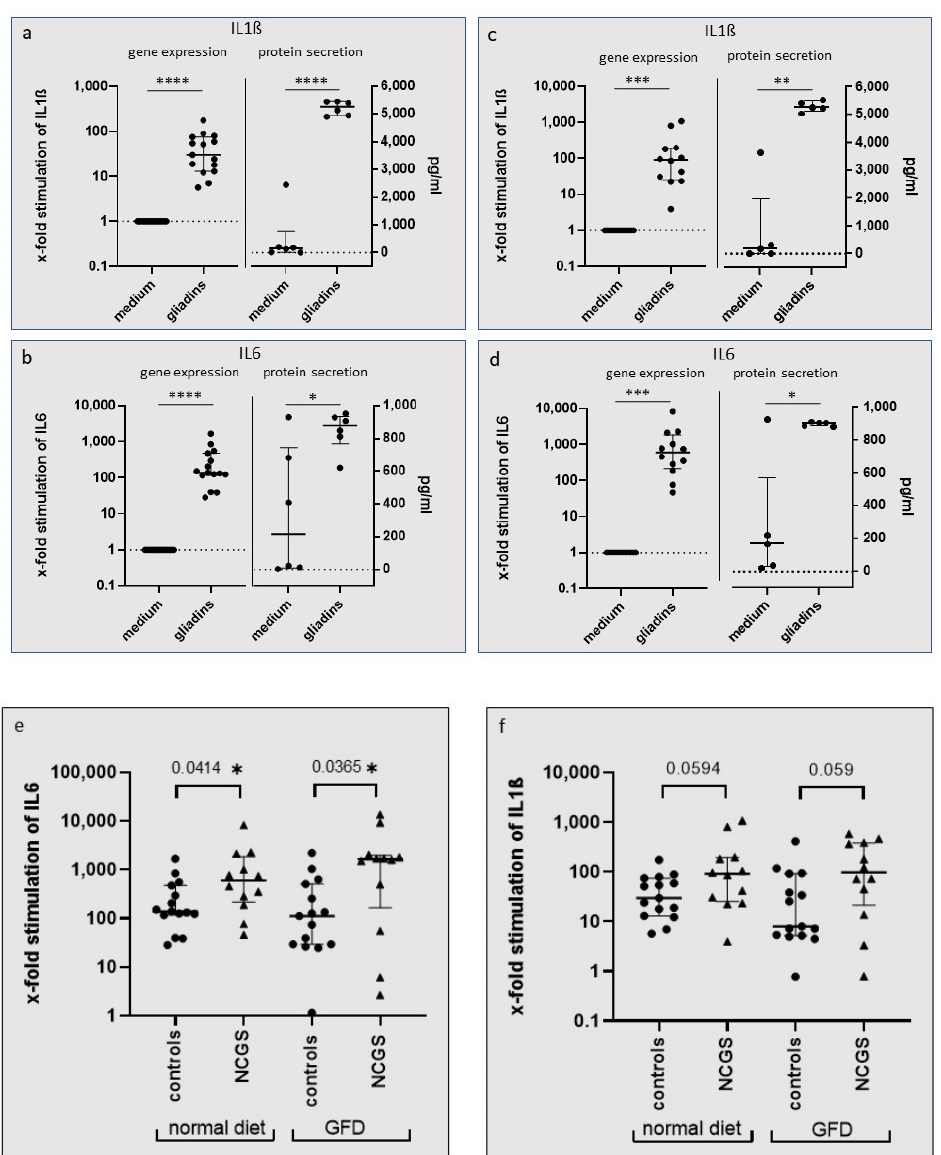
Figure 1. Gene and protein expression of PBMCs after incubation with tryptic-digested gliadins. All results are shown as median with interquartile range. ( a , b ) IL1ß and IL6 expression of PBMCs from healthy controls ( n = 15) and ( c , d ) from patients with NCGS ( n = 12). The Wilcoxon signed rank test revealed significant upregulation of gene expression of PBMCs after stimulation with gliadins. The paired t -test revealed significant differences in gliadin-induced protein secretion of PBMCs in healthy controls ( n = 6) and patients with NCGS ( n = 5). ( e , f ) Gene expression of gliadin stimulated PBMCs under a normal diet and after a 6-week GFD. The Mann–Whitney test was used to detect significant differences in gene expression between NCGS and controls. ( e ) The gliadin-induced expression of IL6 mRNA was significantly higher in the PBMCs of patients with NCGS compared to controls before (with a normal diet) and also after a 6-week GFD. ( f ) Stimulation by gliadins caused a distinct upregulation of IL1ß mRNA in the PBMCs of patients with NCGS compared to controls, although not significantly so. Fold-change gene analysis was carried out with the 2 ΔΔ Ct method, using GAPDH as a housekeeping gene, and was related to values for the culture medium without cereal stimulants as control. * p < 0.05; ** p < 0.01, *** p < 0.005, **** p < 0.0001.